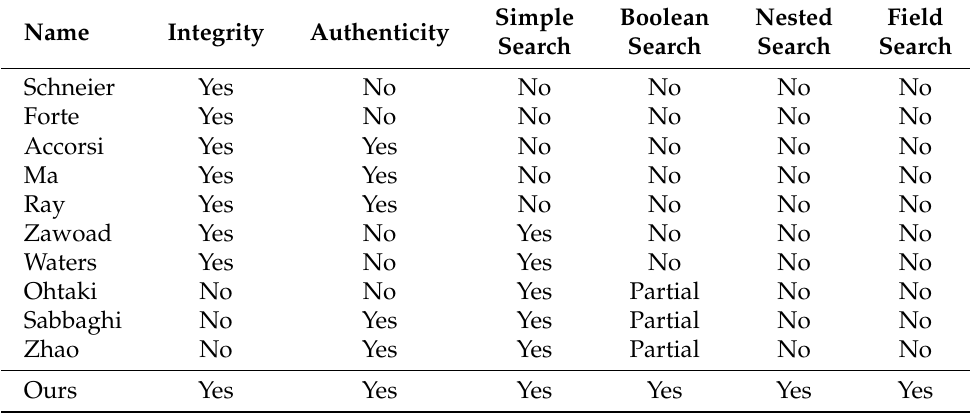
Table 1. Comparison with related work.